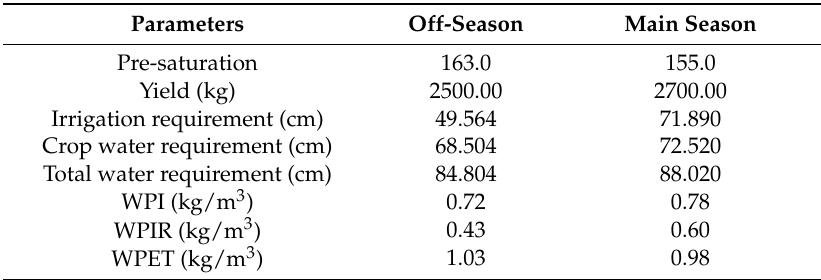
Table 6. Summary of water productivity index, irrigation water requirement, and crop water requirement during both